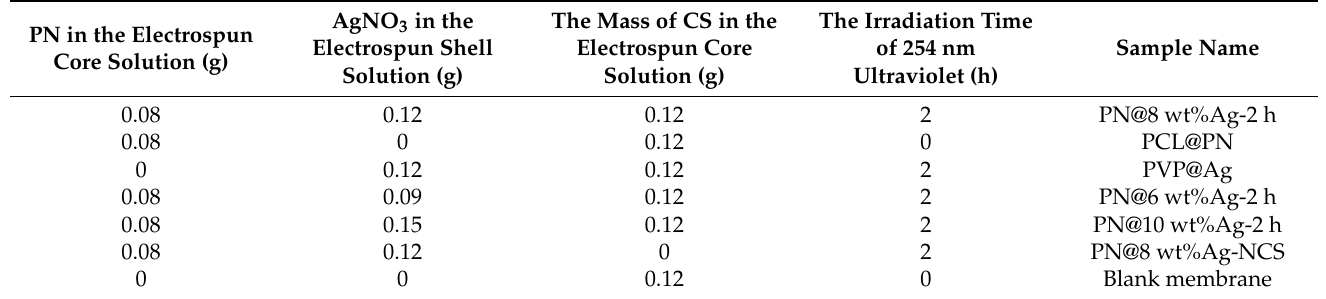
Table 3. The corresponding name of each